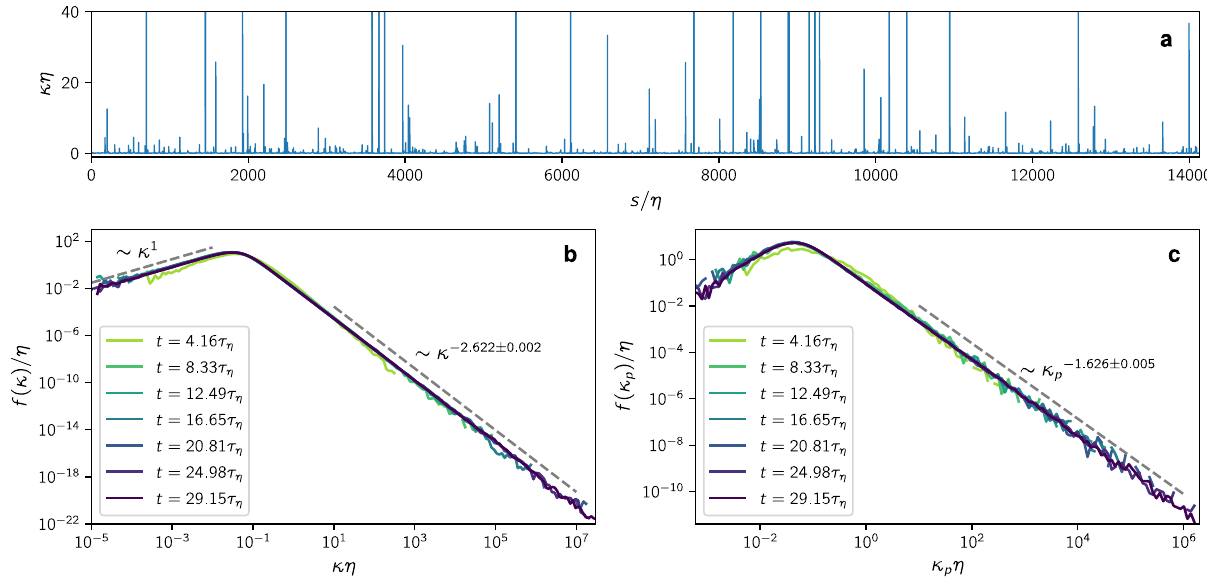
Fig. 2 Localized peaks of curvature along the loop cause heavy-tailed curvature distributions. a Curvature along a material loop at t = 29.15 τ η as a function of arc length s . The function is highly spiked, indicating that high curvature only occurs in isolated narrow regions. These isolated peaks contribute to the high-curvature tails of the curvature PDF. b Curvature PDF of material loops at times t = 4.16 τ η (light green) up to t = 29.15 τ η (violet). c PDF of curvature peaks of material loops at the same times. The high-curvature regime is fi tted by power laws in the regions indicated by the dashed lines by means of a linear fi t to the logarithm of the PDF using binomial error